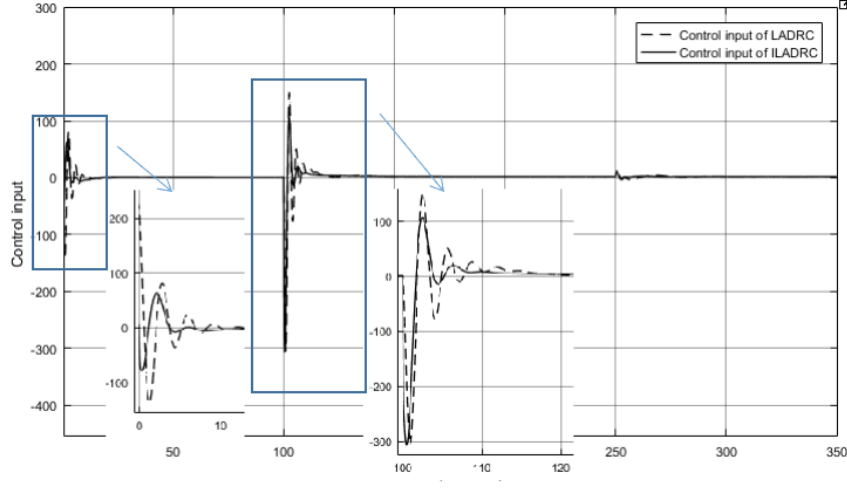
Figure 5. Comparison of control input between LADRC and